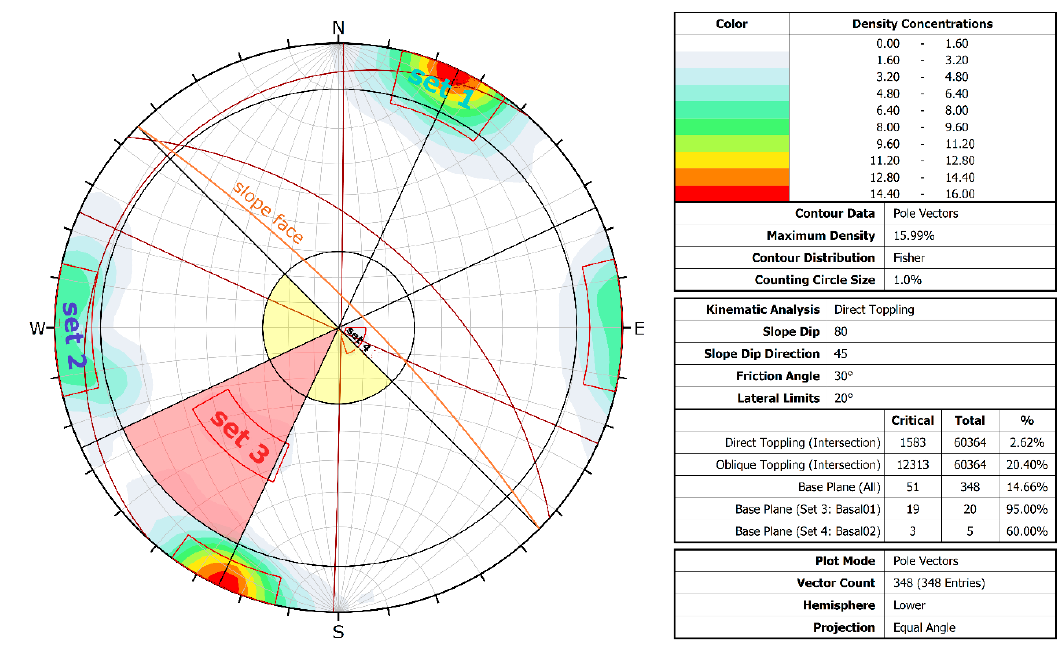
Figure 8. DIPS Stereoplot representation of the discontinuities extracted with SplitFX. The area shaded in red and yellow represents the area of instability highlighted by the kinematic analysis for direct and oblique toppling. The colour code associated with joint sets reflects the mapping performed on SplitFX in Figure 7. Table 1. Summary of the geometrical orientation of the main joint sets identified in SplitFX. Joint Set